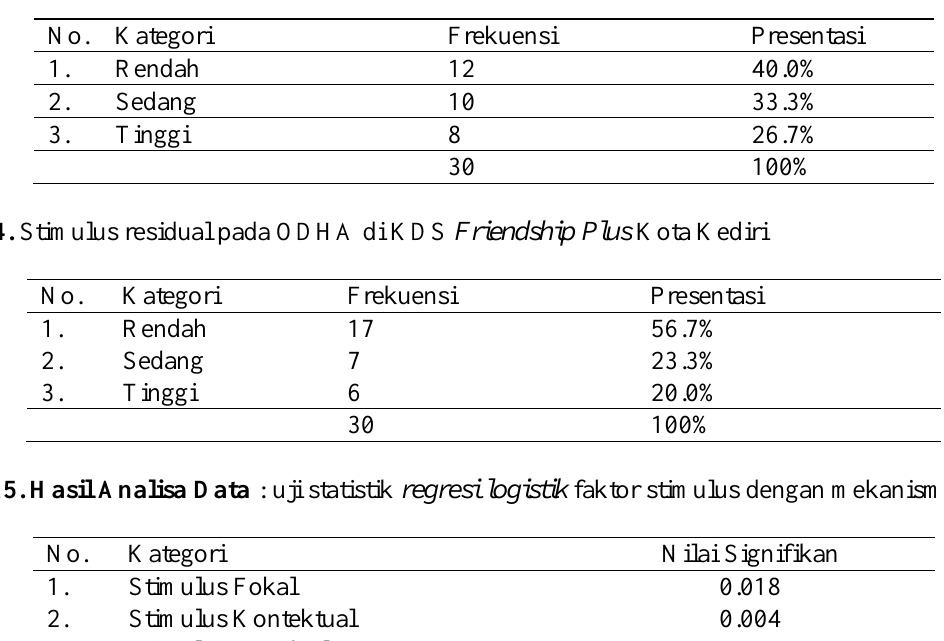
Tabel 3 . Stimulus kontektual pada ODHA di KDS Friendship Plus Kota Kediri